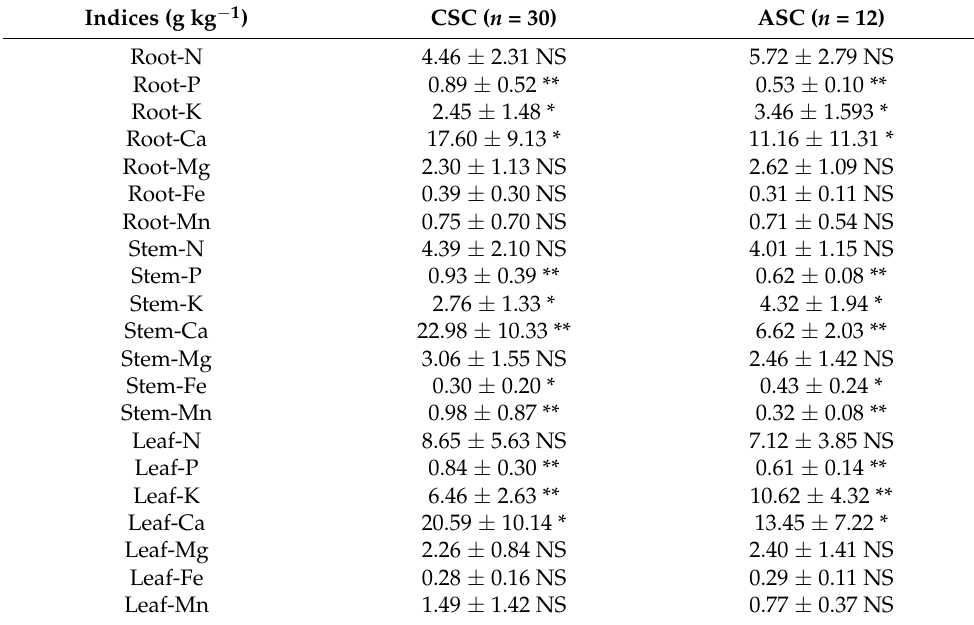
Table 2. Nutrient differences in the roots, stems, and leaves of CSC and ASC.